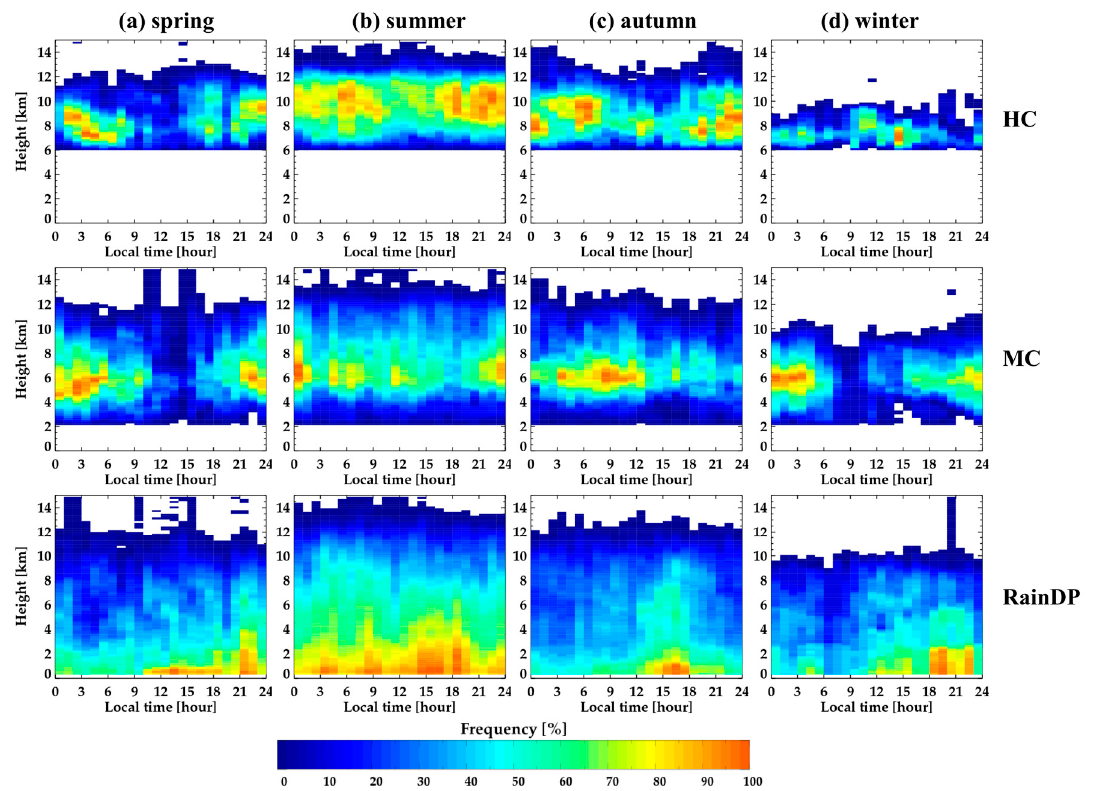
Figure 9. Diurnal variation of cloud occurrence for seasons and the different cloud types. ( a ) Spring, ( b ) summer, ( c ) autumn, and ( d ) winter. (Upper) HC, (middle) MC, and (lower) RainDP.